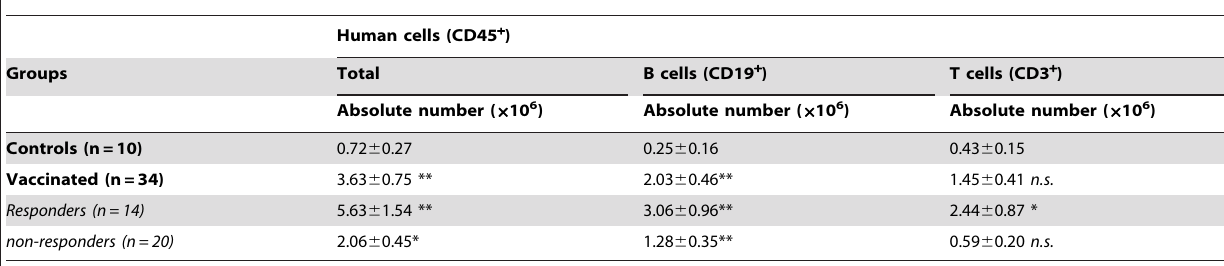
Table 2. Human cell numbers measured in the spleen of vaccinated HIS mice.